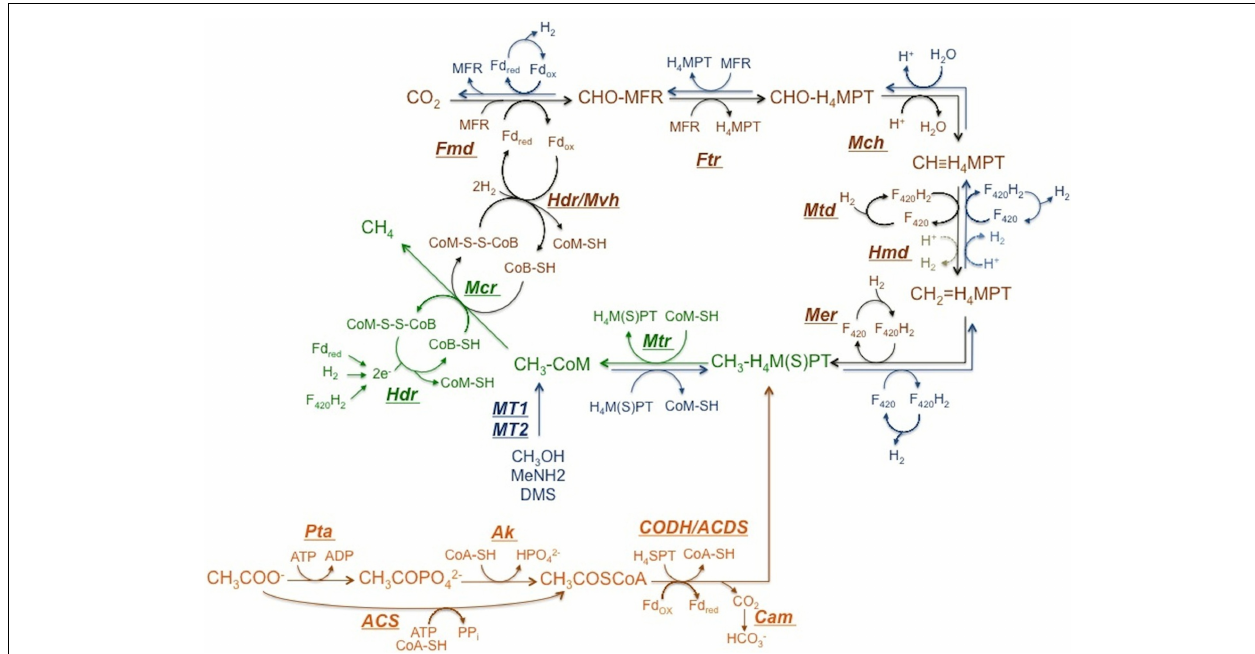
FIGURE 2 | Methanogenic Pathways. Reactions in brown correspond to hydrogenotrophic pathway and reactions in orange belong to the aceticlastic pathway. Reactions in blue represent the pathway employed when methyl group containing C1 compounds are the substrate. Reactions in green are common in all pathways. ATP, adenosine triphosphate; H SPT, tetrahydrosarcinapterin; H 4 4